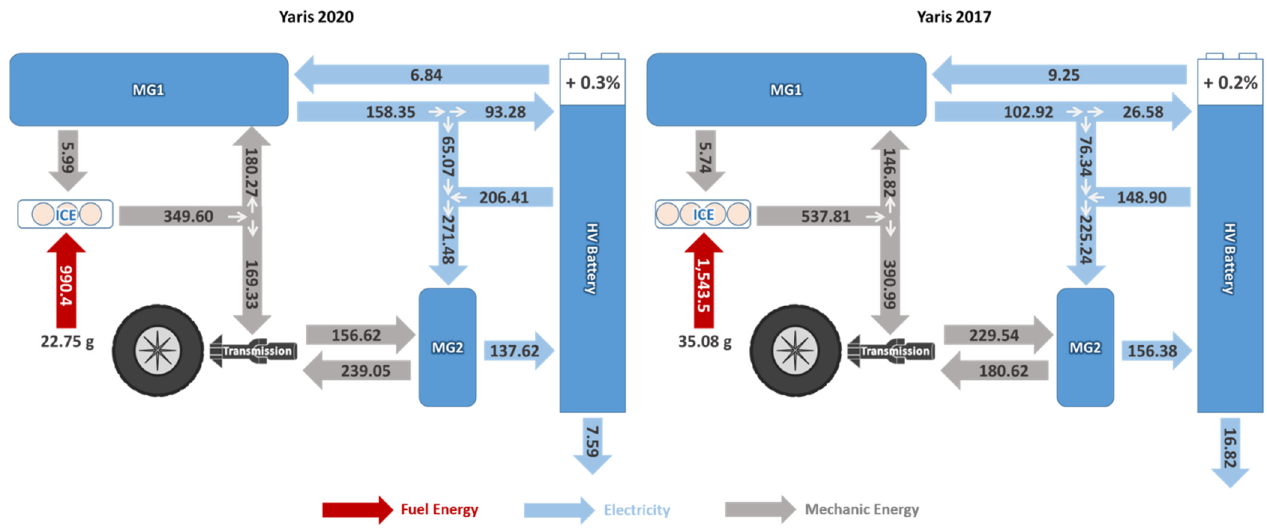
Figure 15. Energy flows of the traction system [kJ/km].